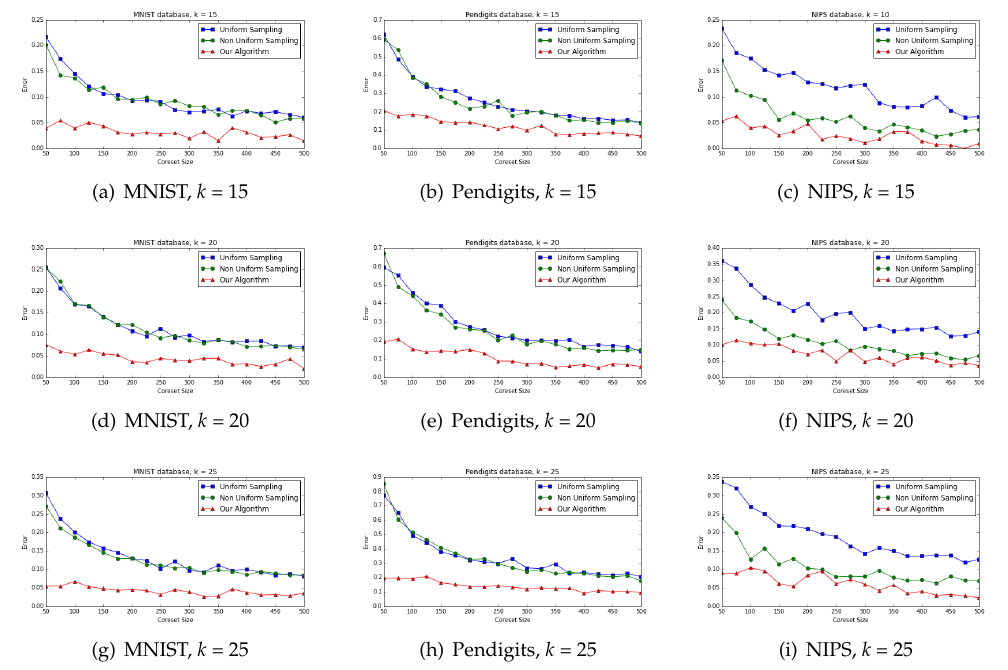
Figure 3. Streaming coresets computation for small datasets (uniform sampling, non uniform sampling and our algorithm).